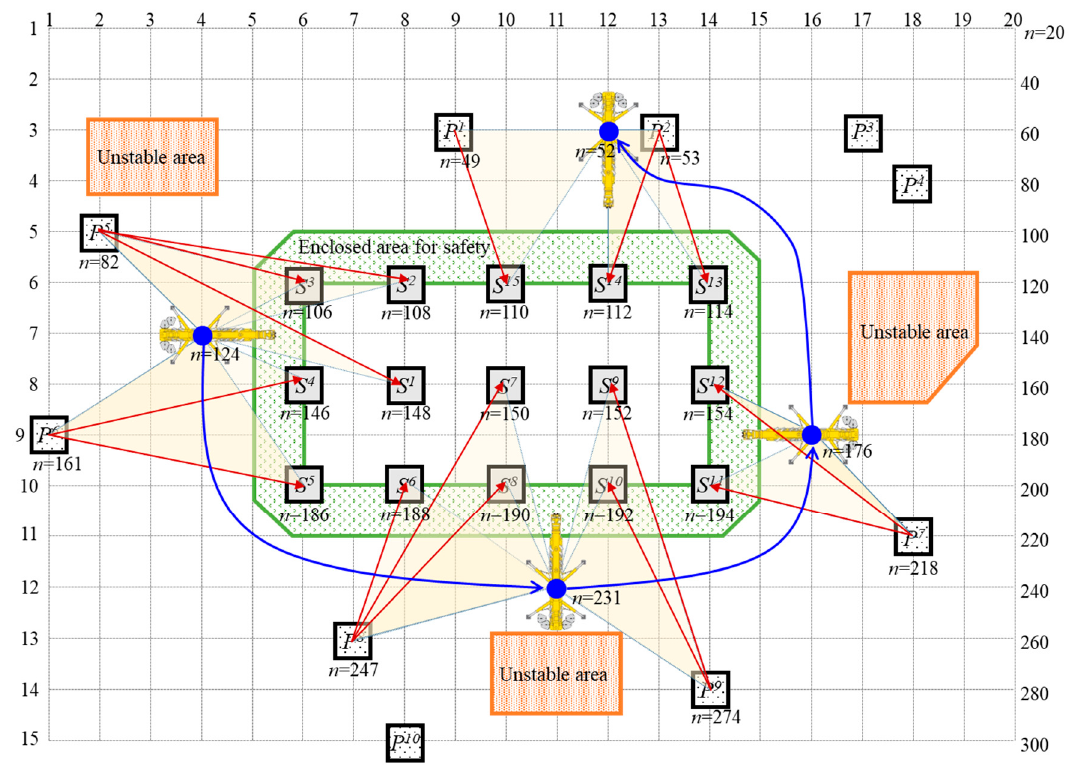
Figure 5. Graphical representation of the results.